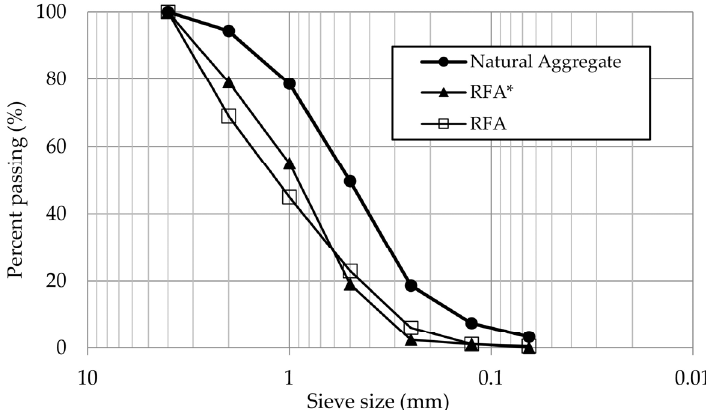
Figure 2. Granulometric curves of aggregates.